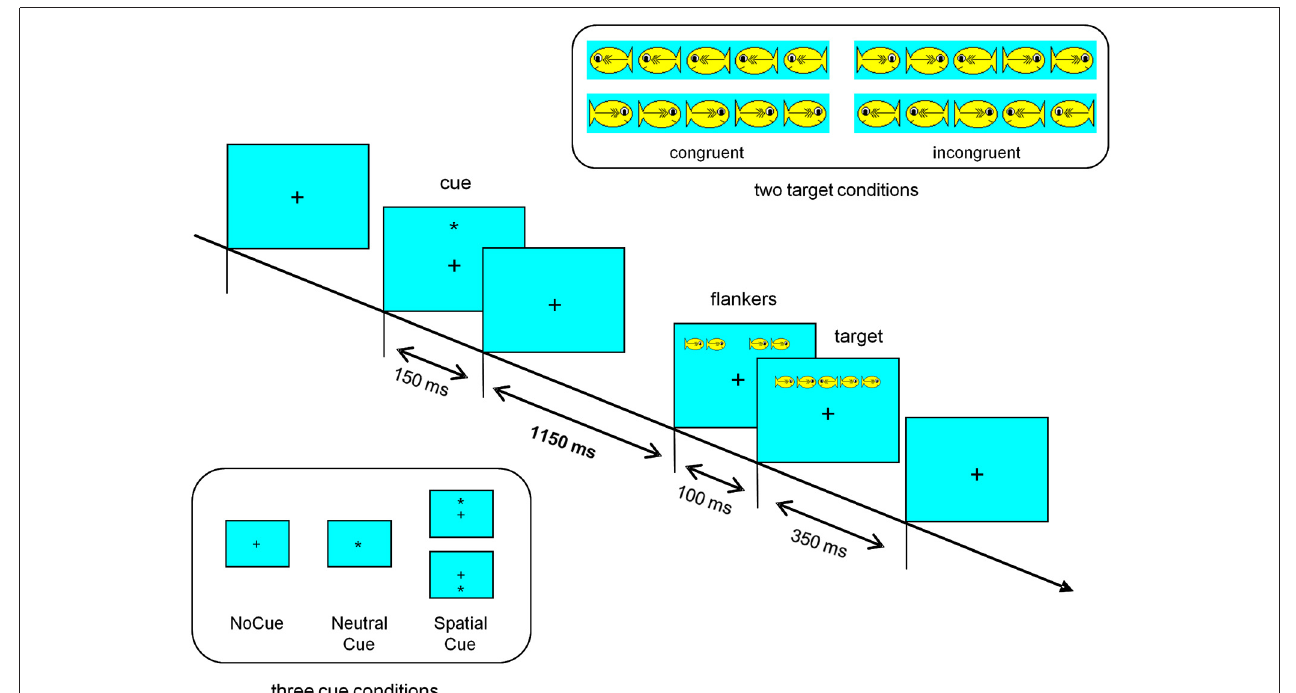
FIGURE 1 | Schematic illustration of the attention network test (ANT) as applied in our study . A fixation cross located on the center of the computer screen was shown during the complete test. The row of hungry fish appeared above or below the fixation cross (about 1 ◦ ). The target fish, i.e., the center fish, was visible for 350 ms. Presentation of the flanking fish started 100 ms before the center fish appeared.